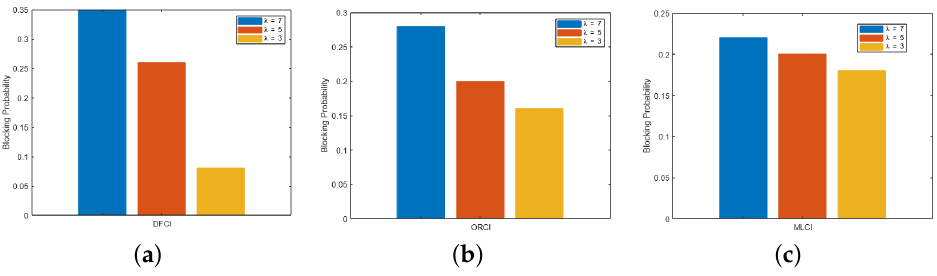
Figure 11. EVs Blocking Probability at Charging Station with Varying Arrival Rates. ( a ) DC Fast Charing Infrastructure. ( b ) On Road Charging Infrastructure. ( c ) Multi-level Charging